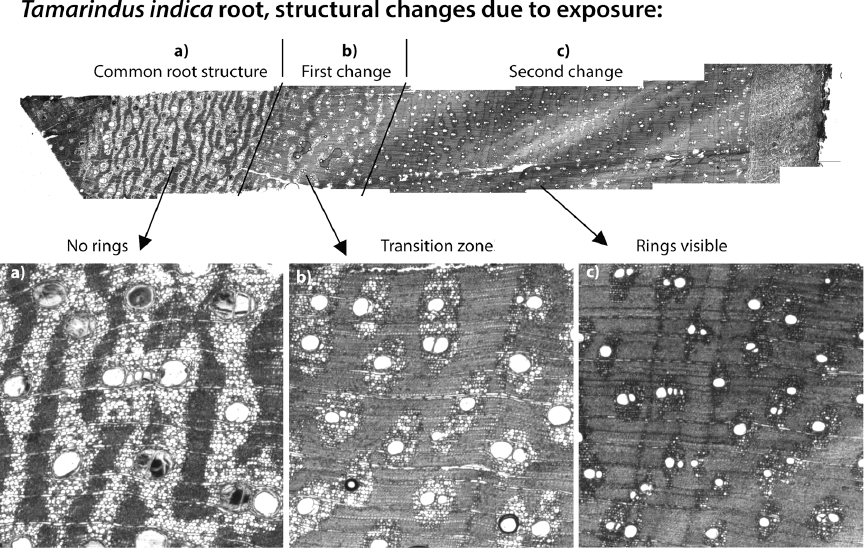
Figure 4. Root micro-section tamarind root sample from the eastern end of the Malaza riverbank.